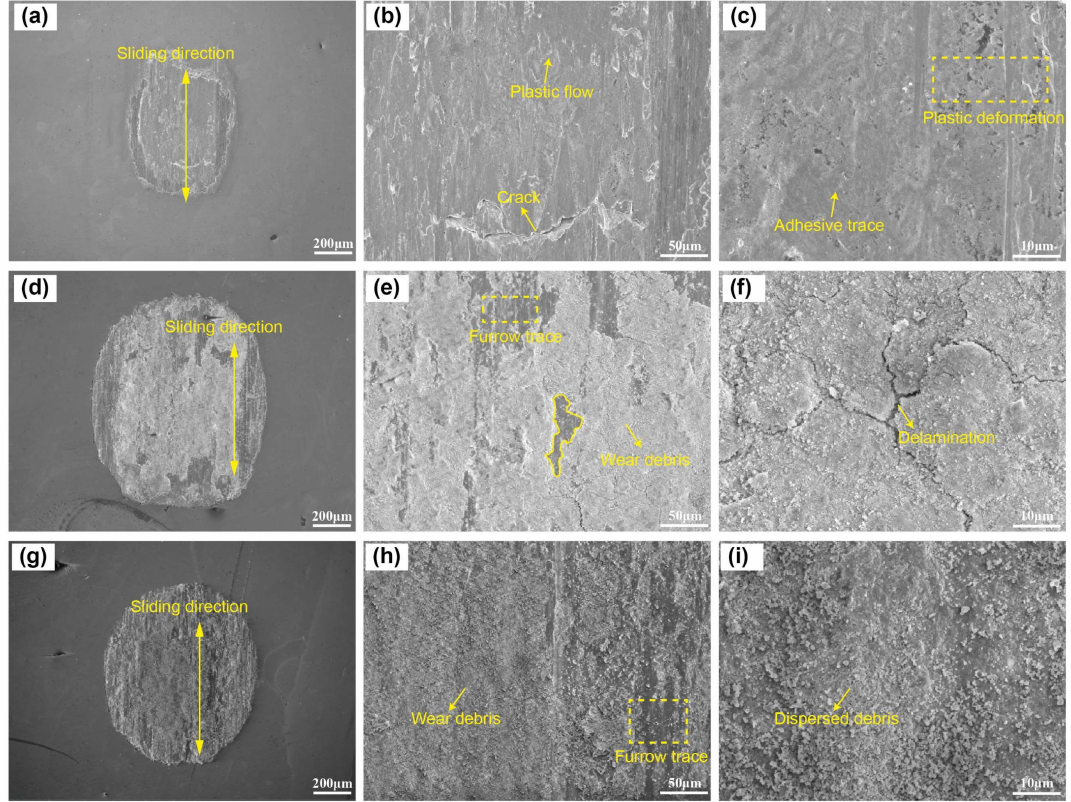
Figure 6. The SEM morphology of worn surface under Ar ( a – c ), Air ( d – f ), and O 2 ( g – i ) conditions.